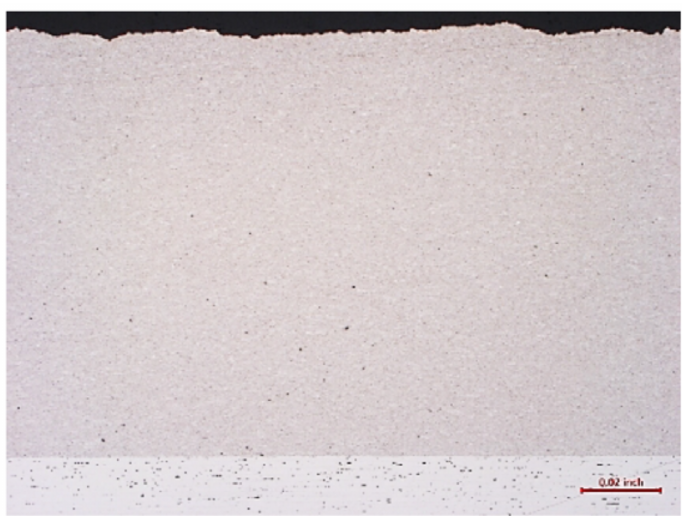
Figure 8. Micrograph depicting typical microstructure observed on aluminium 7075 cold-sprayed coating on aluminium 7075 substrate. As-etched; at 25 ×